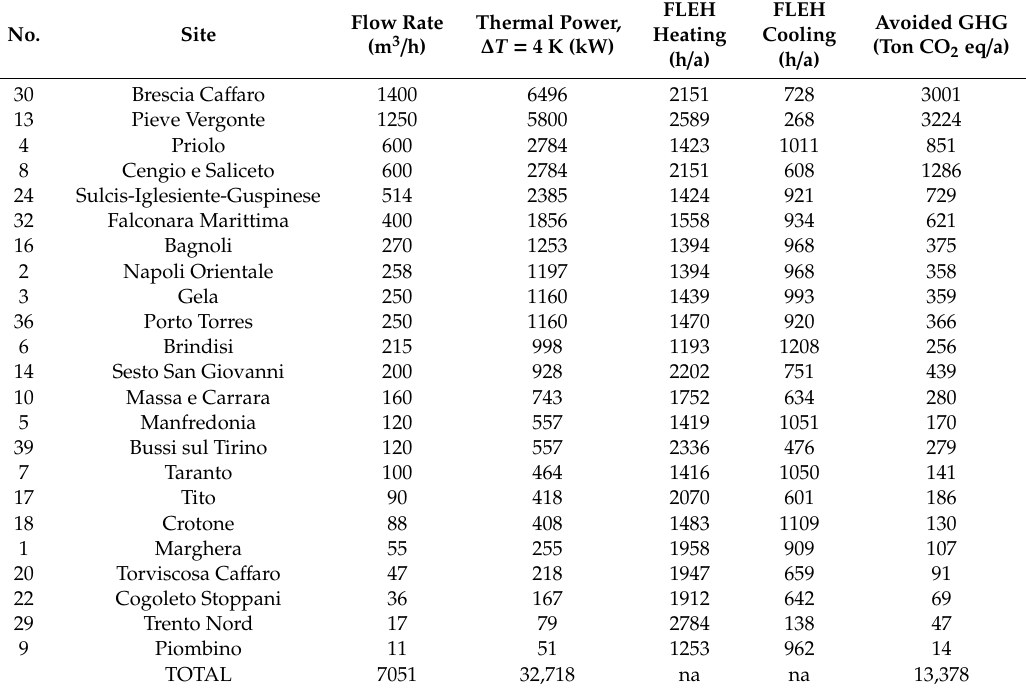
Table 1. Flow rate treated in 23 Italian contaminated sites of national interest (SIN) and thermal power that could be exchanged with P&T